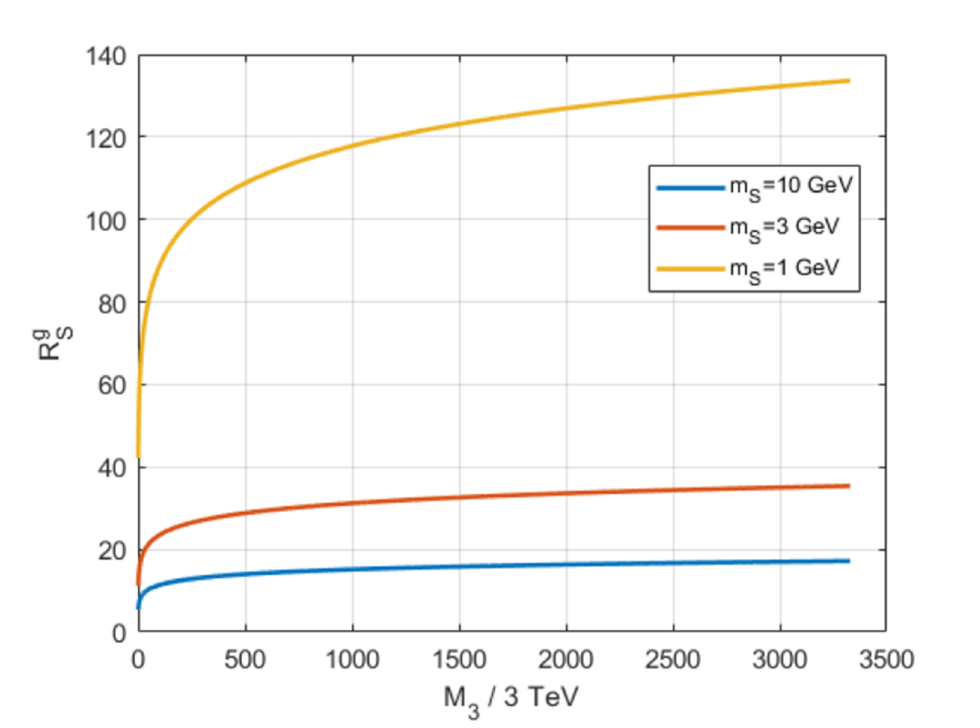
(cid:17) 2 as a function of gluino mass M 3 for a set